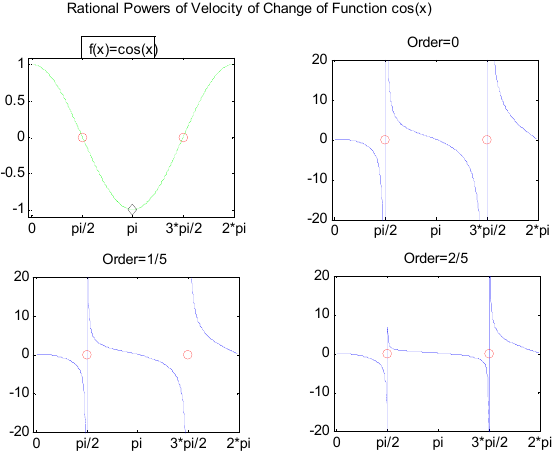
Figure 3. The rational orders of rates of change for the sine function (Orders are 3/5, 4/5, 1).